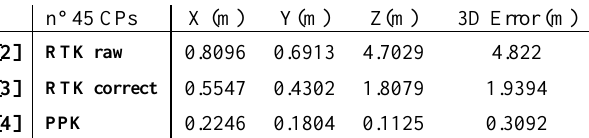
Table 4. Check of RMSE on CPs for the three configurations of georeferenced images blocks